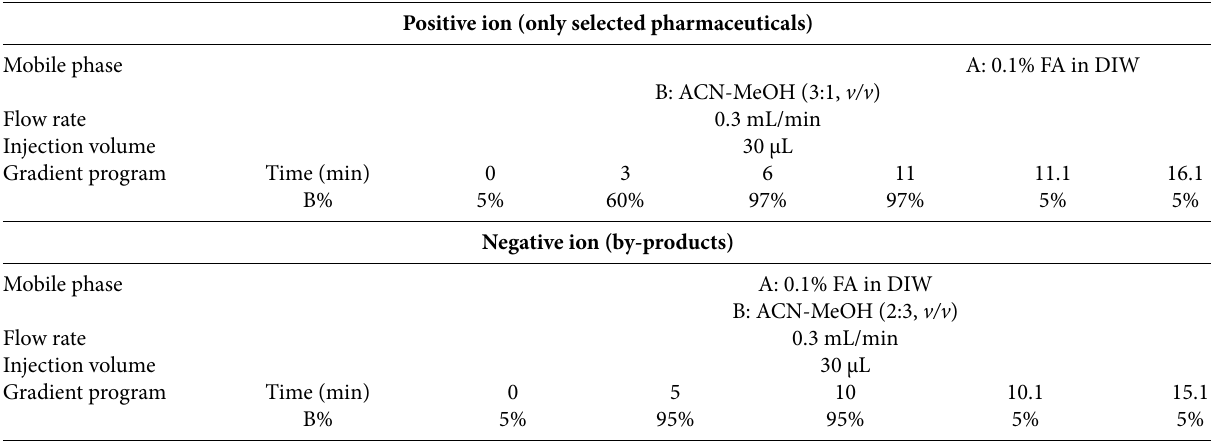
Table 2. Chromatographic separation of selected pharmaceuticals and their by-products for both PI and NI ESI-TOF/MS modes Positive ion (only selected